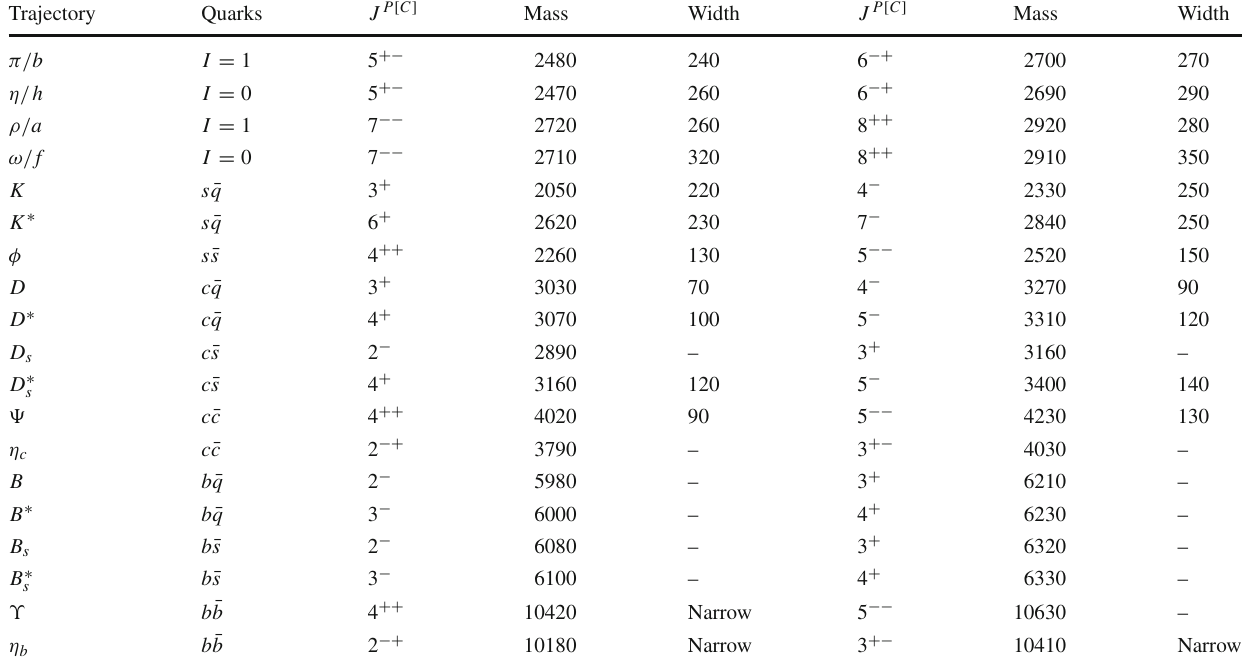
Table 1 Predictions for the next states on the leading HMRTs in the ( J , M 2 ) plane of various types of mesons. q signifies a light quark ( u / d ). Widths are not written where there is not enough data to determine them Trajectory